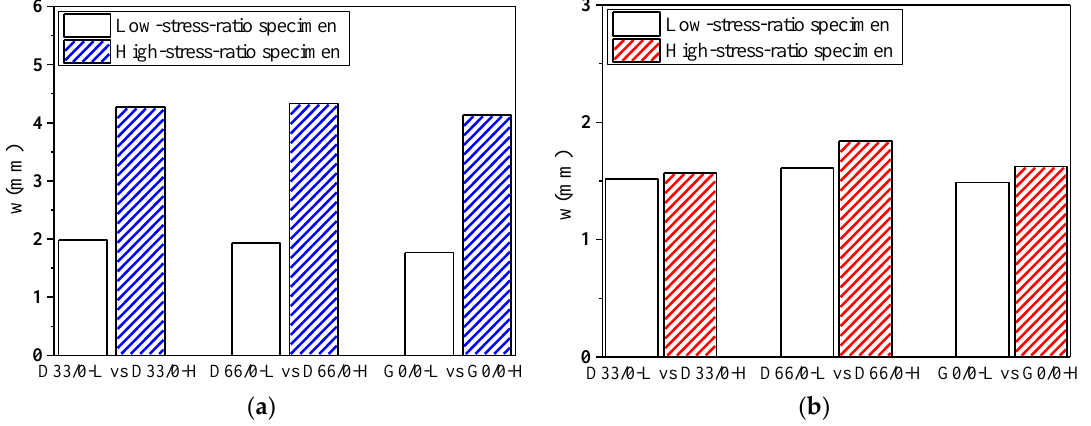
Figure 13. Effect of the stress ratio on the deflection of the specimens. ( a ) Initial deflection of the specimens; ( b ) deflection increases of the specimens with time.